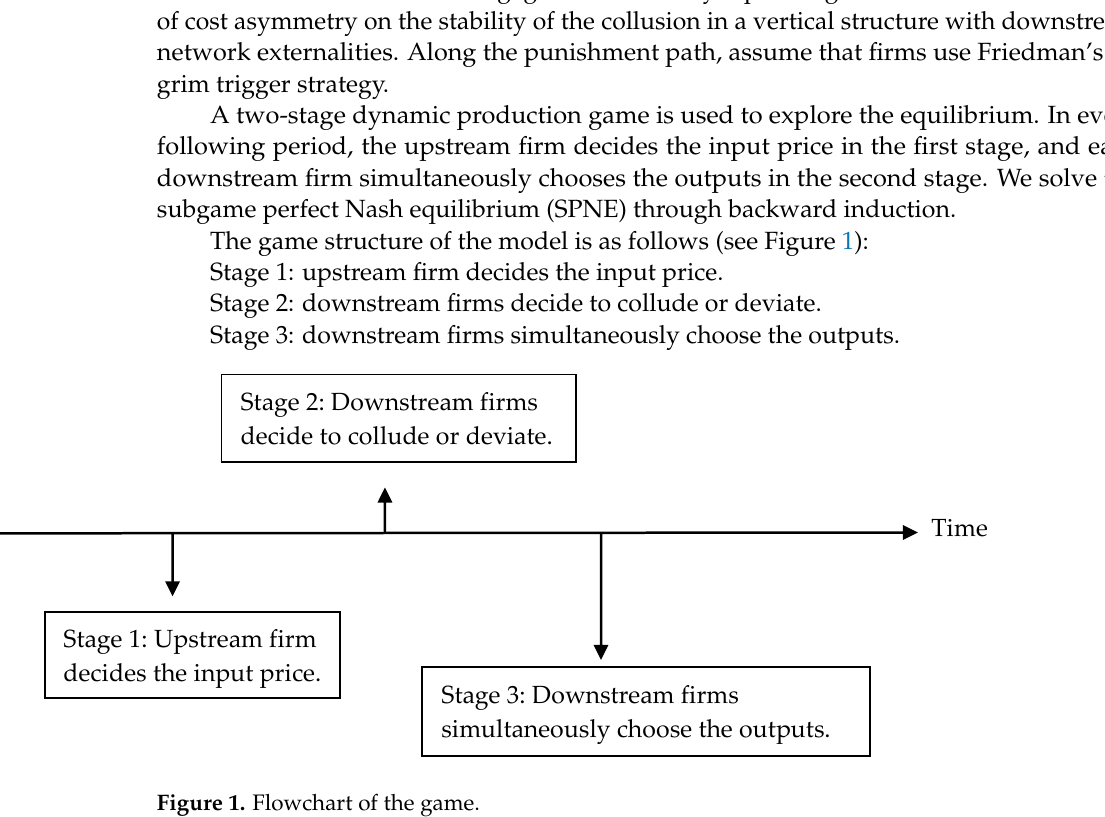
Figure 1. Flowchart of the game.